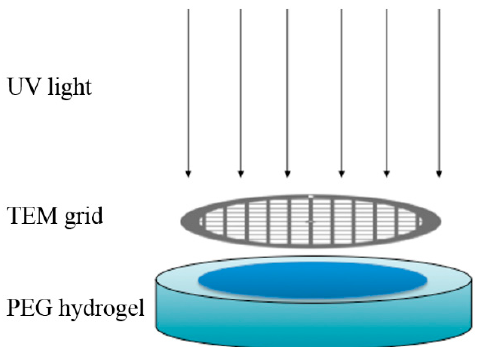
Figure 2. Scheme showing the selective photopolymerization of Acryl-PEG-Anti-GFP on a poly(ethylene) glycol diacrylate (PEGDA) hydrogel using a TEM grid as a